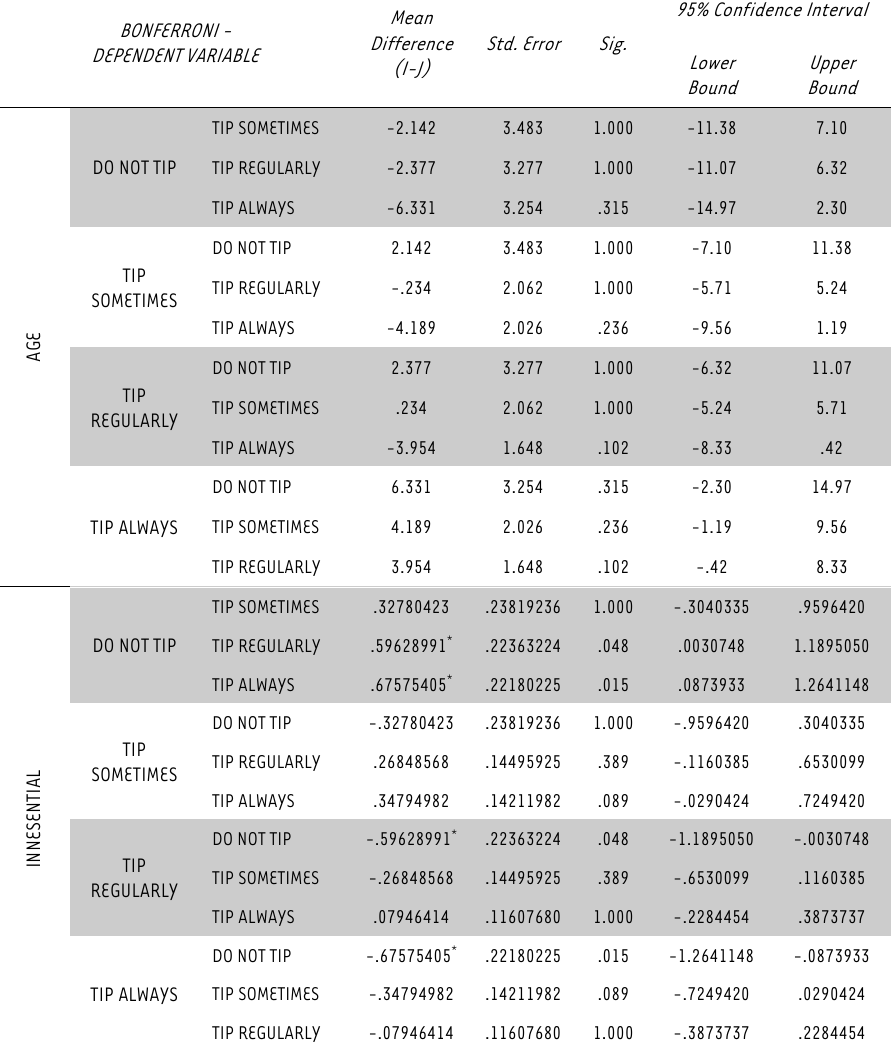
TABLE 3: Bonferroni